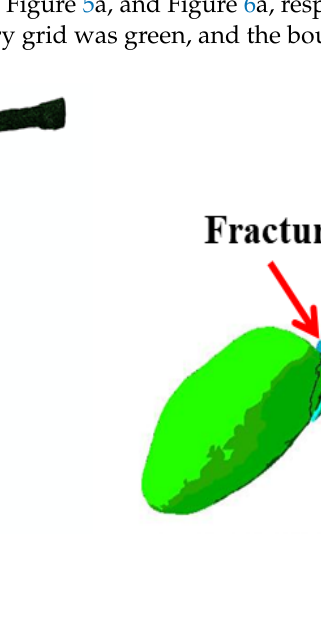
Figure 2. The meshed model ( a ) and the result ( b ) of the ripe fruit in the detachment simulation.